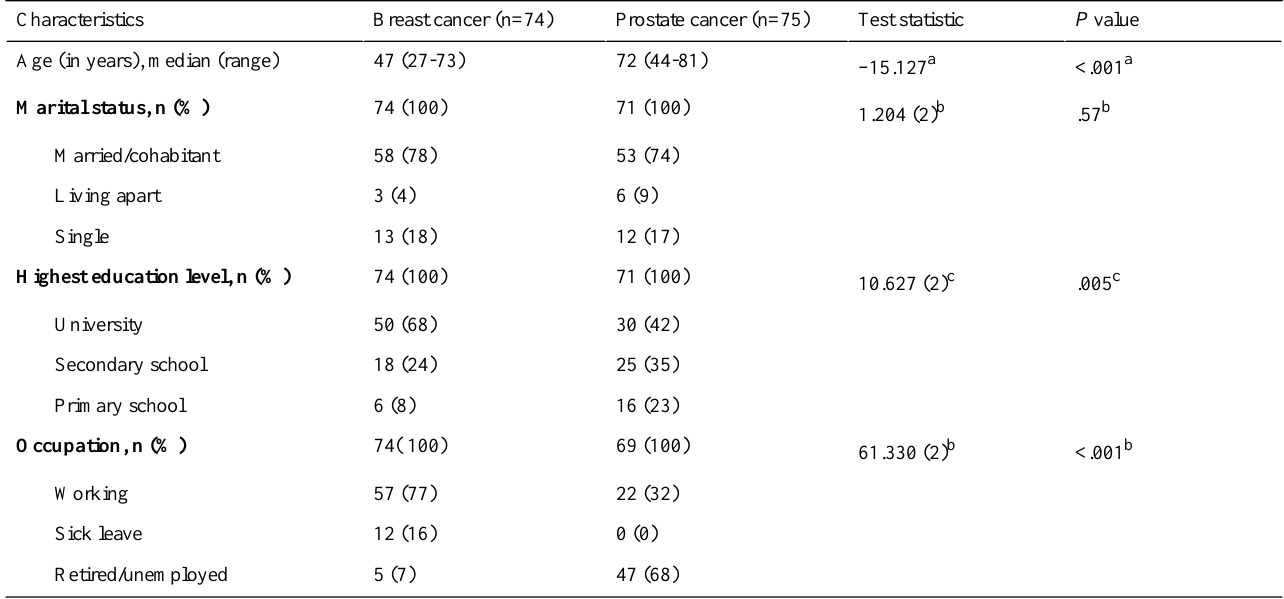
Table 2. Sociodemographic characteristics at baseline of patients with breast cancer and prostate